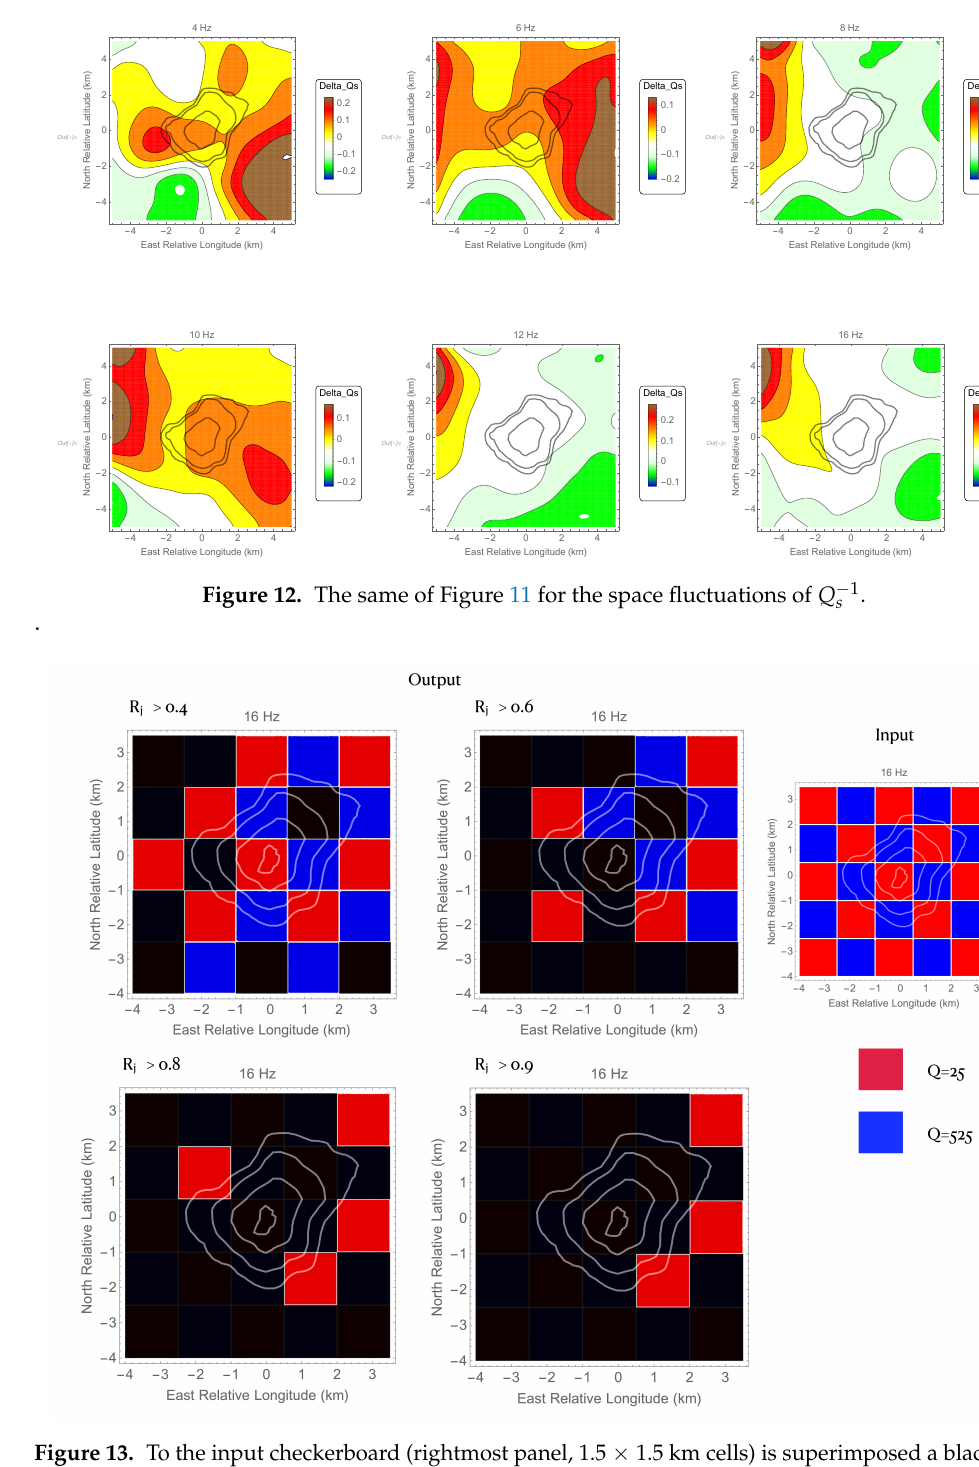
Figure 13. To the input checkerboard (rightmost panel, 1.5 × 1.5 km cells) is superimposed a black cell when R j of Equation (25) is smaller than 0.4 (upper left panel), 0.6 (upper right panel), 0.8 (down left panel), and 0.9 (down right panel). Once assumed, an acceptable level for R j , for example, R j > 0.6, the cells with insufficient resolution are colored in black. We remark here that the quantity R j is just proportional to the Resolution. In other words these plots are useful for a relative comparison among different images, once that a given value of R j is assumed for all the